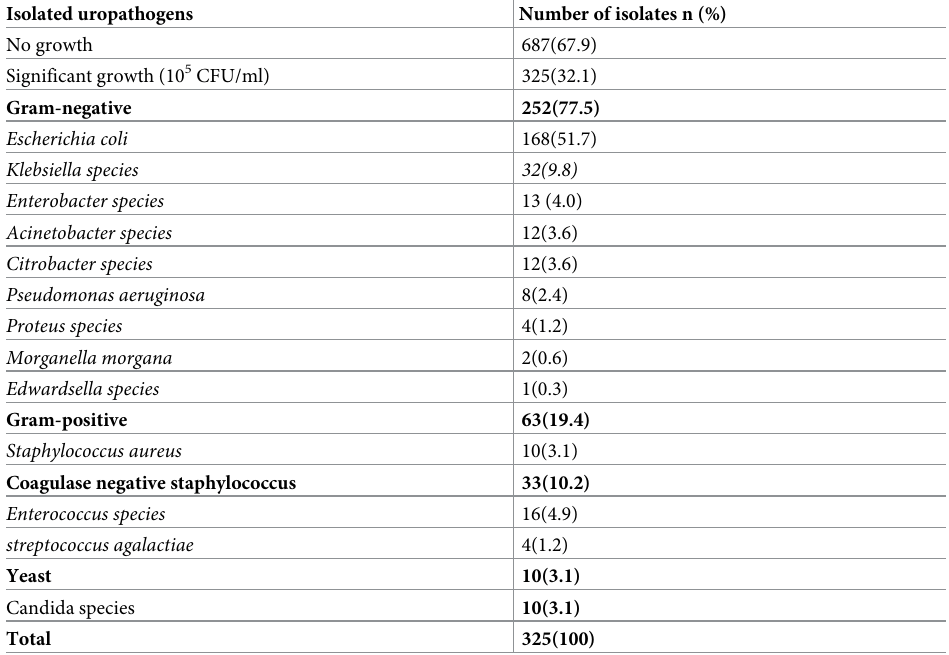
Table 2. Distribution of uropathogenic microorganisms among patients with urinary tract